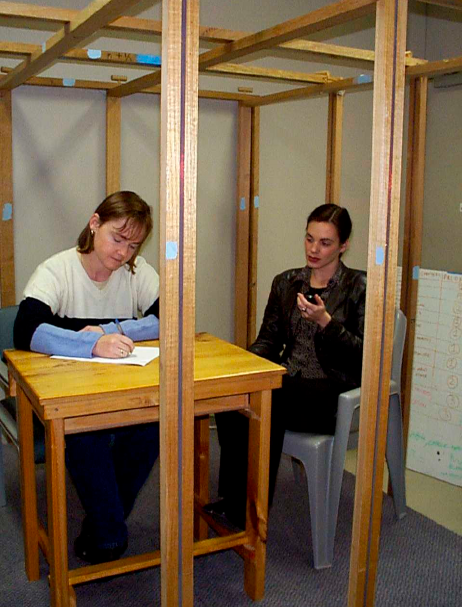
Figure 2. The ELF exposure system consisting of orthogonal square Helmholtz coils with spit windings—this allows current to flow both during sham (cancelling mode) and field (augmenting mode) to avoid audible cues due to the 50 Hz “hum”. The two sets of coils are 90 ° out-of-phase, giving rise to circularly-polarized fields, similar to those near power transmission lines. All items within the coils are made from non-ferrous materials. The central region with 0.8 m radius has a field uniformity within 2%.